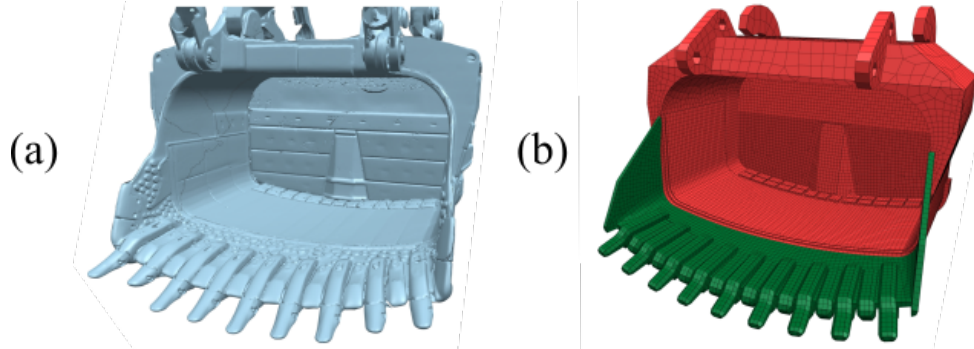
Figure 6. Geometry and model of the Esco bucket. ( a ) 3D scanned bucket, ( b ) the FE-model.